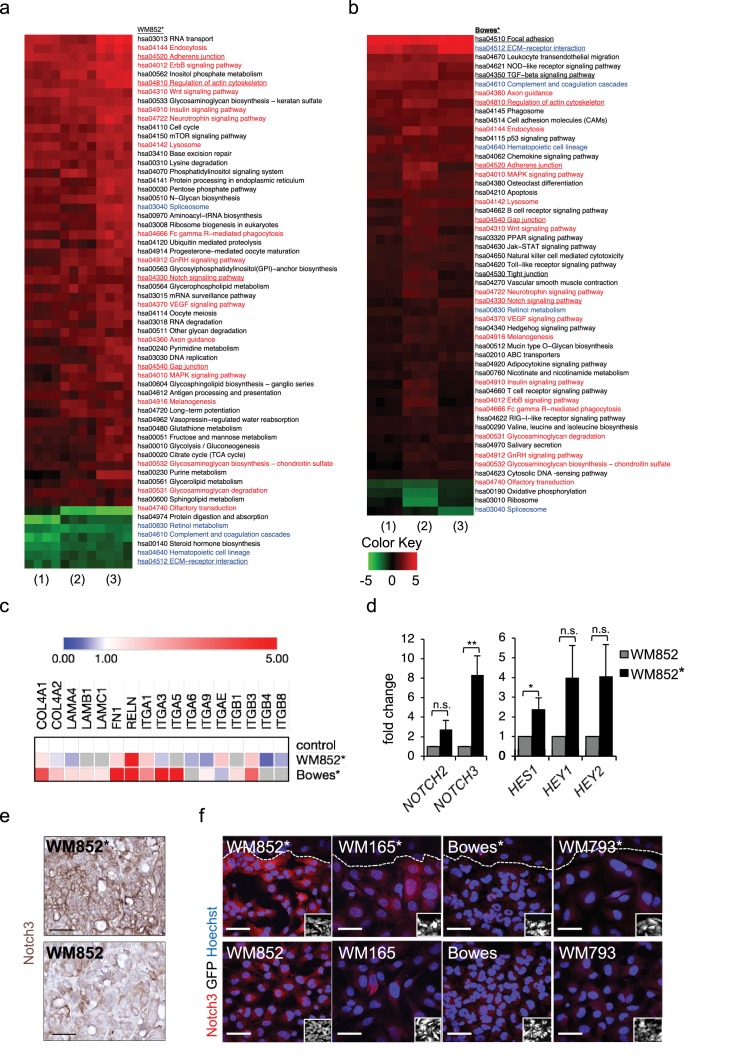
Transcriptomic analysis reveals Notch3 upregulation in the LEC primed WM852 cells.(a–b) Generally Applicable Gene-set Enrichment (GAGE) for RNA-seq pathway analysis of LEC primed (a) WM852* and (b) Bowes* cells. Samples were compared to their respective cells derived from monotypic cultures. Three biological replicates per sample group and four run replicates were used. In the heatmap, red represents upregulated and green downregulated pathways in WM852* and Bowes*. Pathways enriched in both cell lines are marked with red text if they were similarly upregulated or downregulated, and blue text if they were differentially upregulated or downregulated. Pathways enriched only in one cell line are marked with black text. Pathways with underlined text were used for further analysis. (c) Heatmap depicting average expression fold change of the differentially expressed ECM-receptor interaction pathway genes in the RNA-seq of LEC primed WM852* and Bowes* cells. The WM852 and Bowes cells from monotypic cultures were used as controls, and set to one. Red represents upregulated and blue downregulated genes in WM852* and Bowes*. Adjusted p-values are less than 0.05 for all genes shown. (d) Relative mRNA fold change of the indicated targets in WM852 and WM852*. *:p<0.05; **p<0.001; n.s., non-significant. (e) Representative images of Notch3 immunohistochemistry in the WM852 and WM852* derived xenografts. Scale bar = 50 µm. (f) Representative confocal images of Notch3 staining (red) in different GFP expressing melanoma cell lines (GFP positive cells shown in the inset) cultured in the presence (*, upper panels) or absence (bottom panels) of LECs. Nuclei are counterstained with Hoechst 33342. The dashed line indicates the LEC-melanoma (below the line) border. Scale bar = 50 µm. Full size confocal images are available as a source data 1.